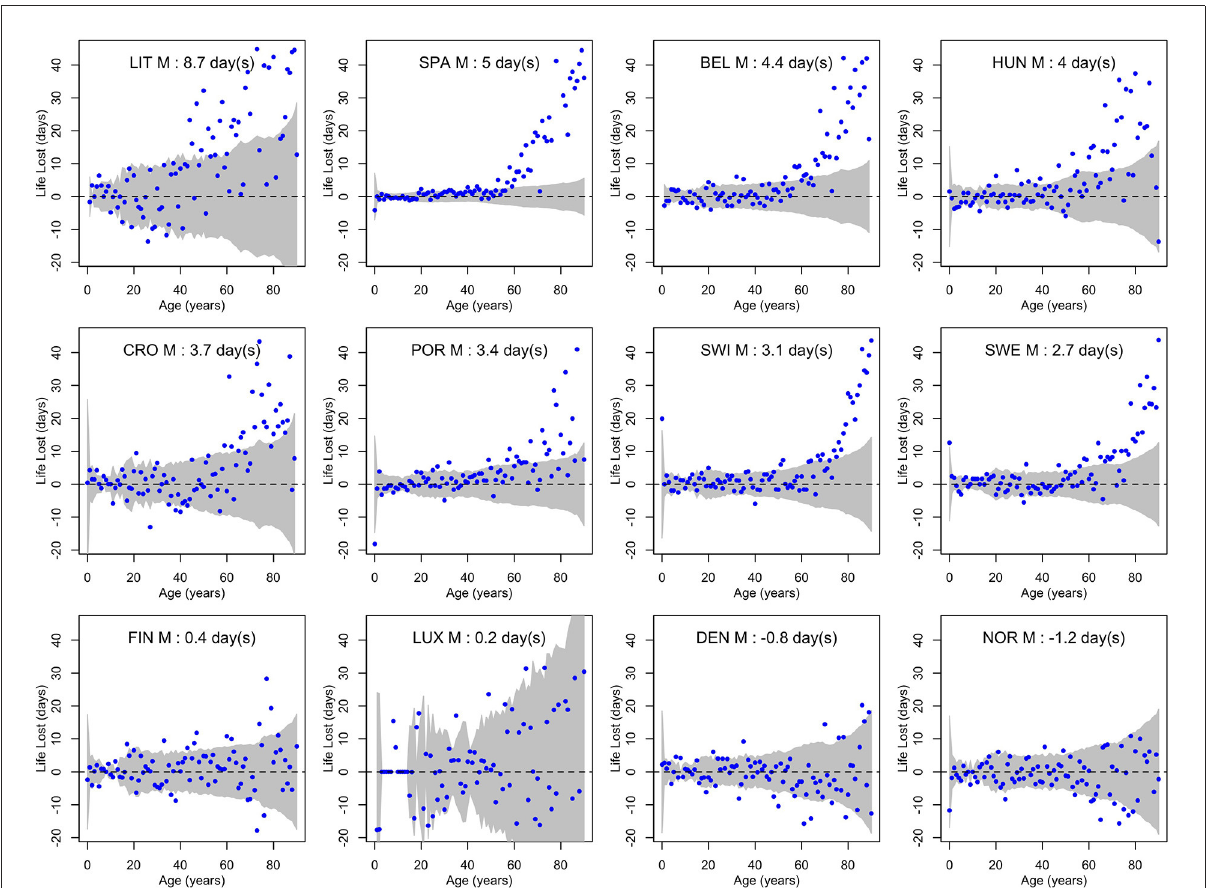
FIGURE3 Life losses in 2020 ( L 2020 x ) at ages x between 0 and 90 for men (M) of 12 European countries, together with 95% prediction intervals calculated under the null hypothesis of a similar mortality as the year before. At the top, population life loss in 2020 ( PLL 2020 , expressed in days) calculated as weighted average of life losses at the different ages x is